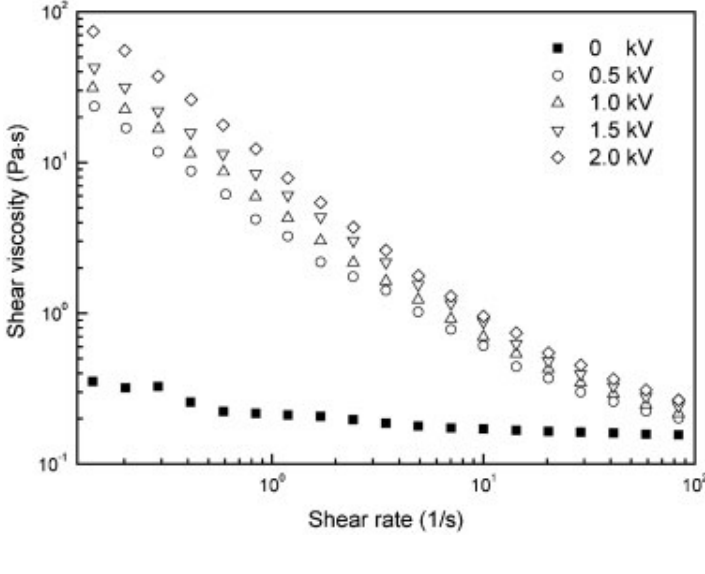
Figure 12. Flow curve of MWNT/PMMA particle based ER fluid under various electric fields (reprinted with permission from [33], Copyright 2007